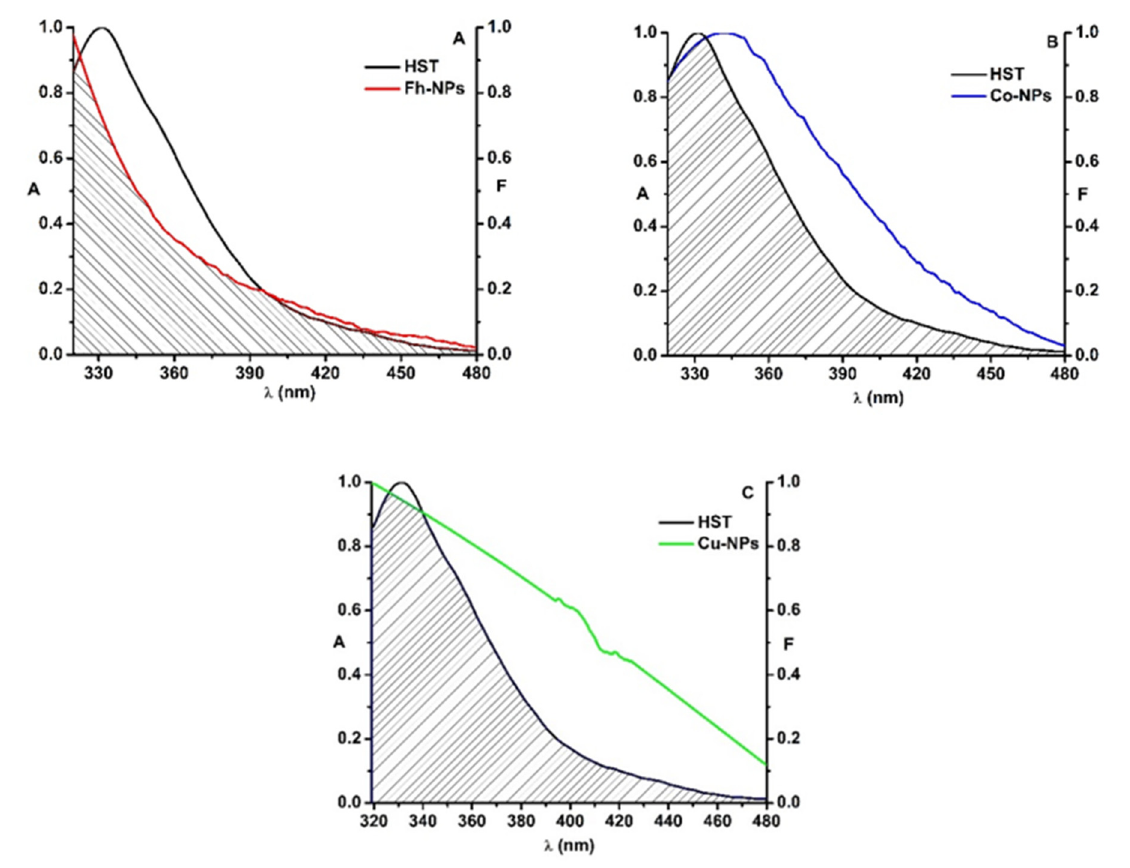
Figure 4. The overlap of the fluorescence emission spectrum of HST (black) and the absorption spectrum of Fh-NPs (red, A ), Co-Fh-NPs (blue, B ), Cu-Fh-NPs (green, C ) and ([HST]: [NPs] = 1:1).